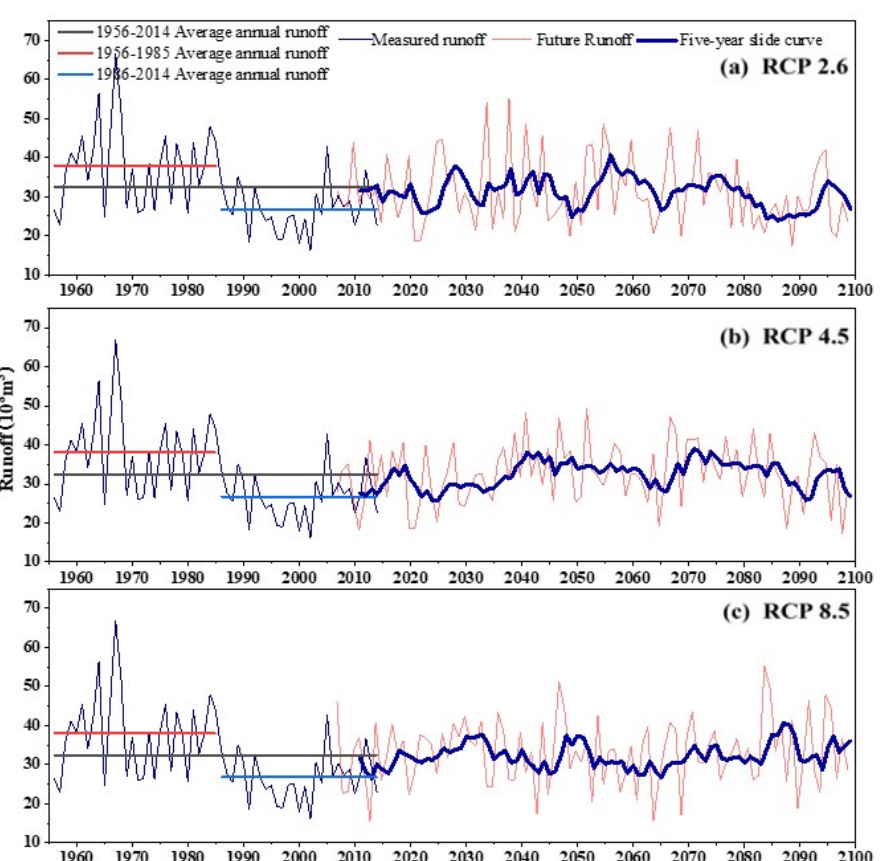
Figure 7. The future changes in runoff at different scenarios in the upper Taohe River Basin, ( a ) RCP2.6 ( b ) RCP4.5 ( c ) RCP8.5. ( b ) RCP4.5 ( c ) RCP8.5.